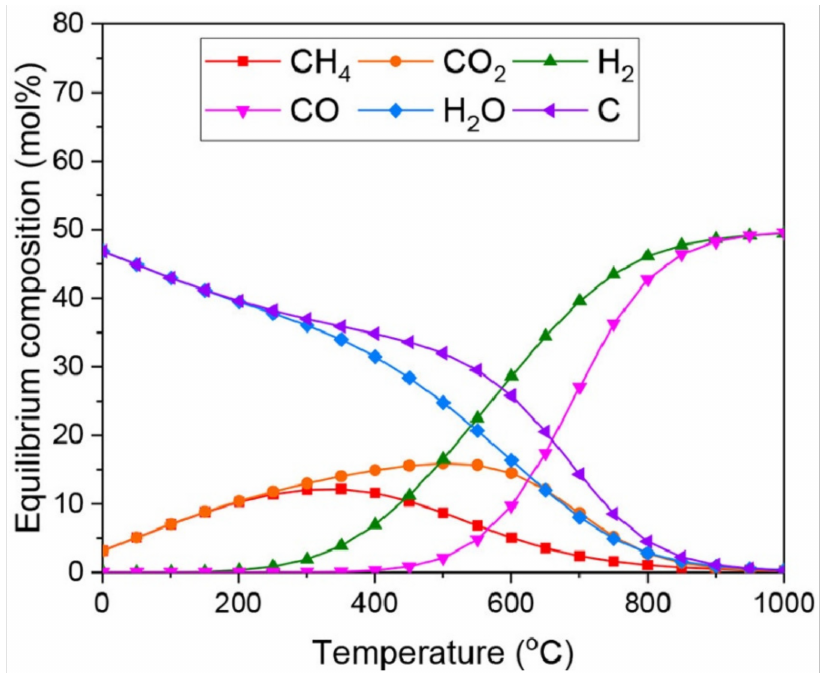
Figure 1. Thermodynamic equilibrium plot for DRM as a function of temperature (T = 0–1000 ◦ C) at 1 bar and CH 4 /CO 2 = 1. Reprinted from [5] in the terms of CC-BY license. Copyright 2022